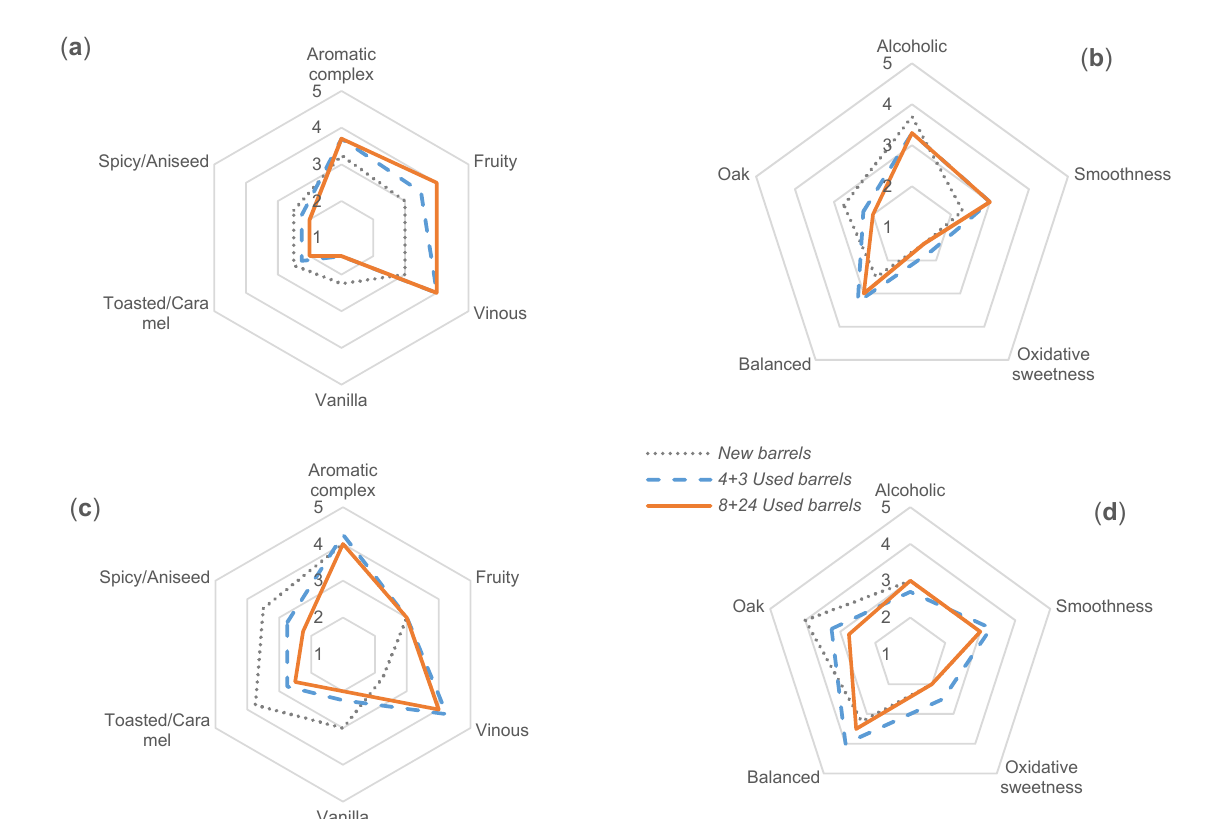
Figure 5. Radar charts of the tasting results of brandies aged for 1 and 2 years in barrels with different previous usage: New barrels , 4 + 3 Used barrels , 8 + 24 Used barrels . ( a ) Odor evaluation after 1 year of ageing; ( b ) Flavor evaluation after 1 year of ageing; ( c ) Odor evaluation after 2 years of ageing; ( d ) Flavor evaluation after 2 years of ageing (Legend in Figure 5d).